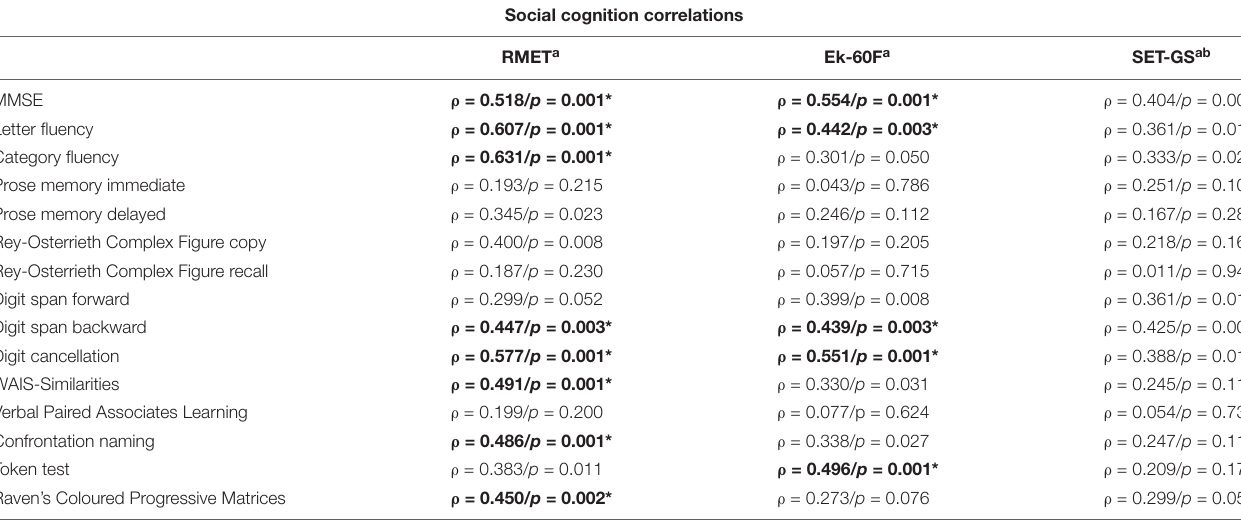
TABLE 3 | Non-parametric correlations between social cognition and neuropsychological measures.